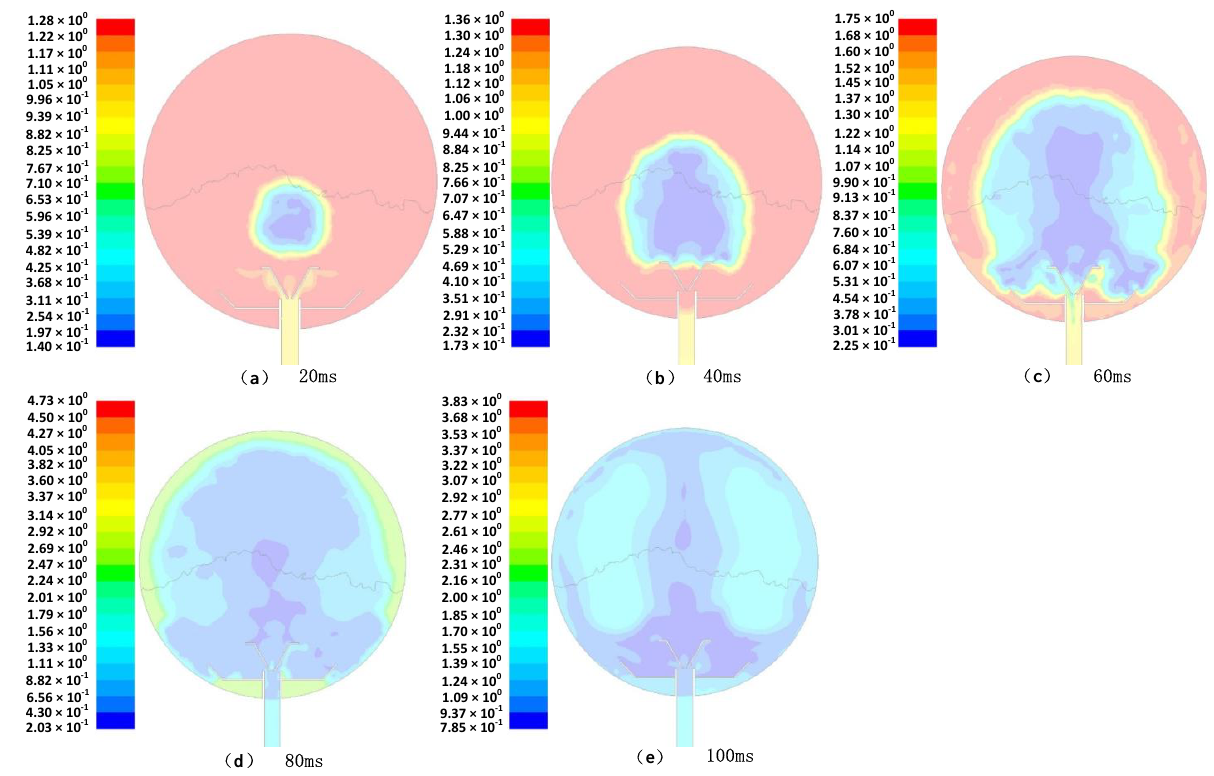
Figure 14. Change in